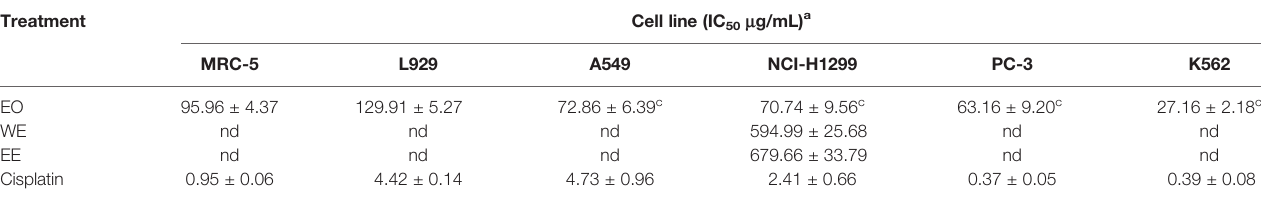
TABLE 4 | Cytotoxic activity of H. fl avum rhizome EO, WE and EE using MTT assay.